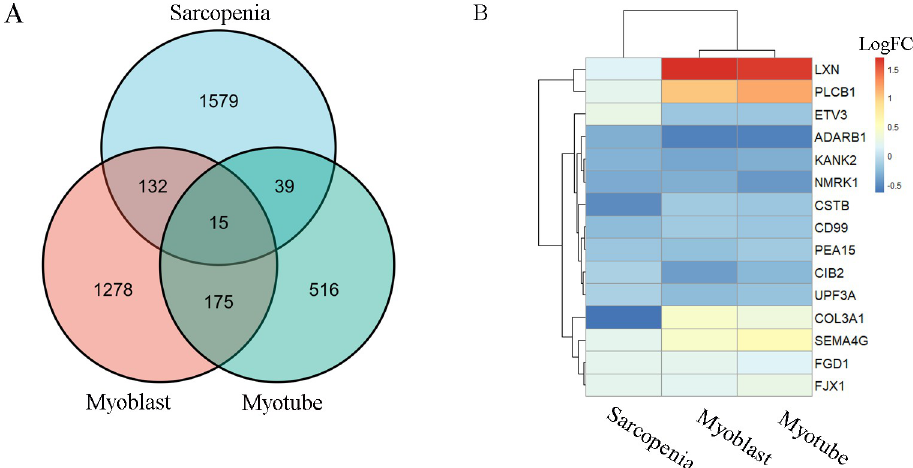
Fig 2. Identification of shared DEGs between sarcopenia and diabetes. (A) Overlap of DEGs represented through a Venn diagram. 15 genes were found common from 147 genes for interaction genes of sarcopenia versus proliferating myoblasts and 54 genes for interaction genes of sarcopenia versus differentiated myotubes. (B) Heat map for the shared DEGs of sarcopenia and T2DM according to the log-fold change.